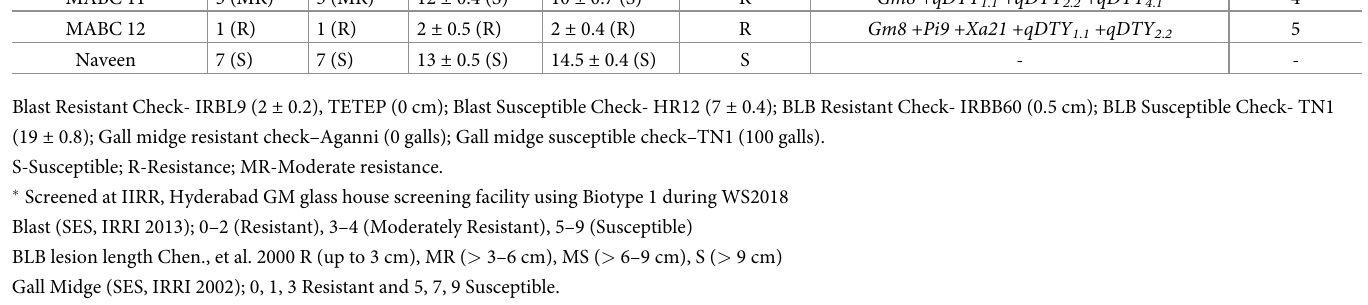
(DRR Dhan44) were used in this study. In MAFB lines, all the traits showed significant varia- tion in drought stress compared to control. The mean DTF varied from 87 to 99 days in con- trol trial and 68 to 96 days under drought stress trial, while the parental DTF is 95 days in control and 87 days under drought stress. Whereas the PH, PT, PL and TGW significantly decreased under drought stress compared to control (Table 3) . In control conditions, MAFB lines showed lower GY compared to the parent Naveen. The mean GY of the Naveen under control was recorded as 6253 kg ha -1 and the mean GY of the pyramided lines were ranged from 1868 to 4370 kg ha -1 . Meanwhile under drought stress, the mean GY of Naveen was 1267 kg ha -1 and the GY of the MAFB lines was ranged from 855 to 2406 kg ha -1 . Three lines